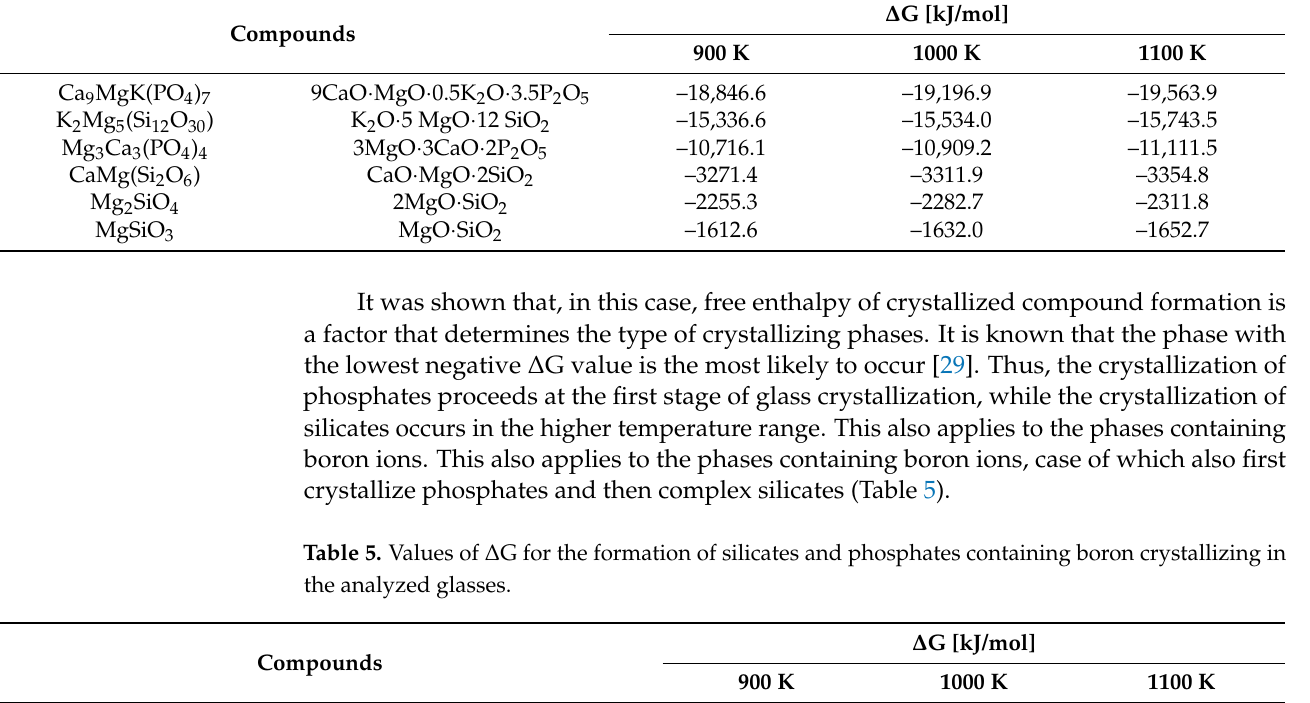
Table 4. Values of ∆ G for the formation of silicates and phosphates crystallizing in the analyzed glasses. Compounds